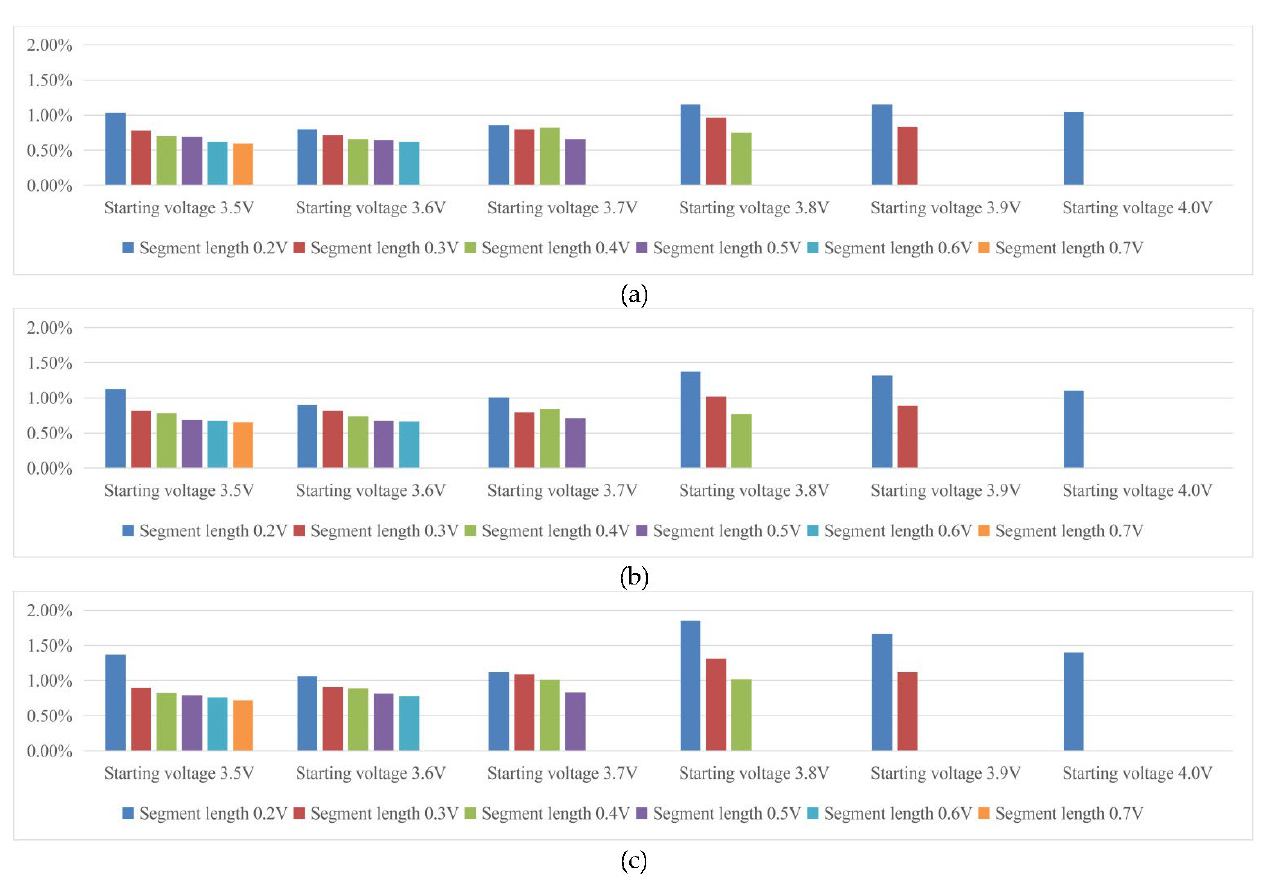
Figure 6. MAE of SOH estimation: ( a ) sampling interval of 0.01 V, ( b ) sampling interval of 0.02 V, ( c ) sampling interval of 0.05 V.